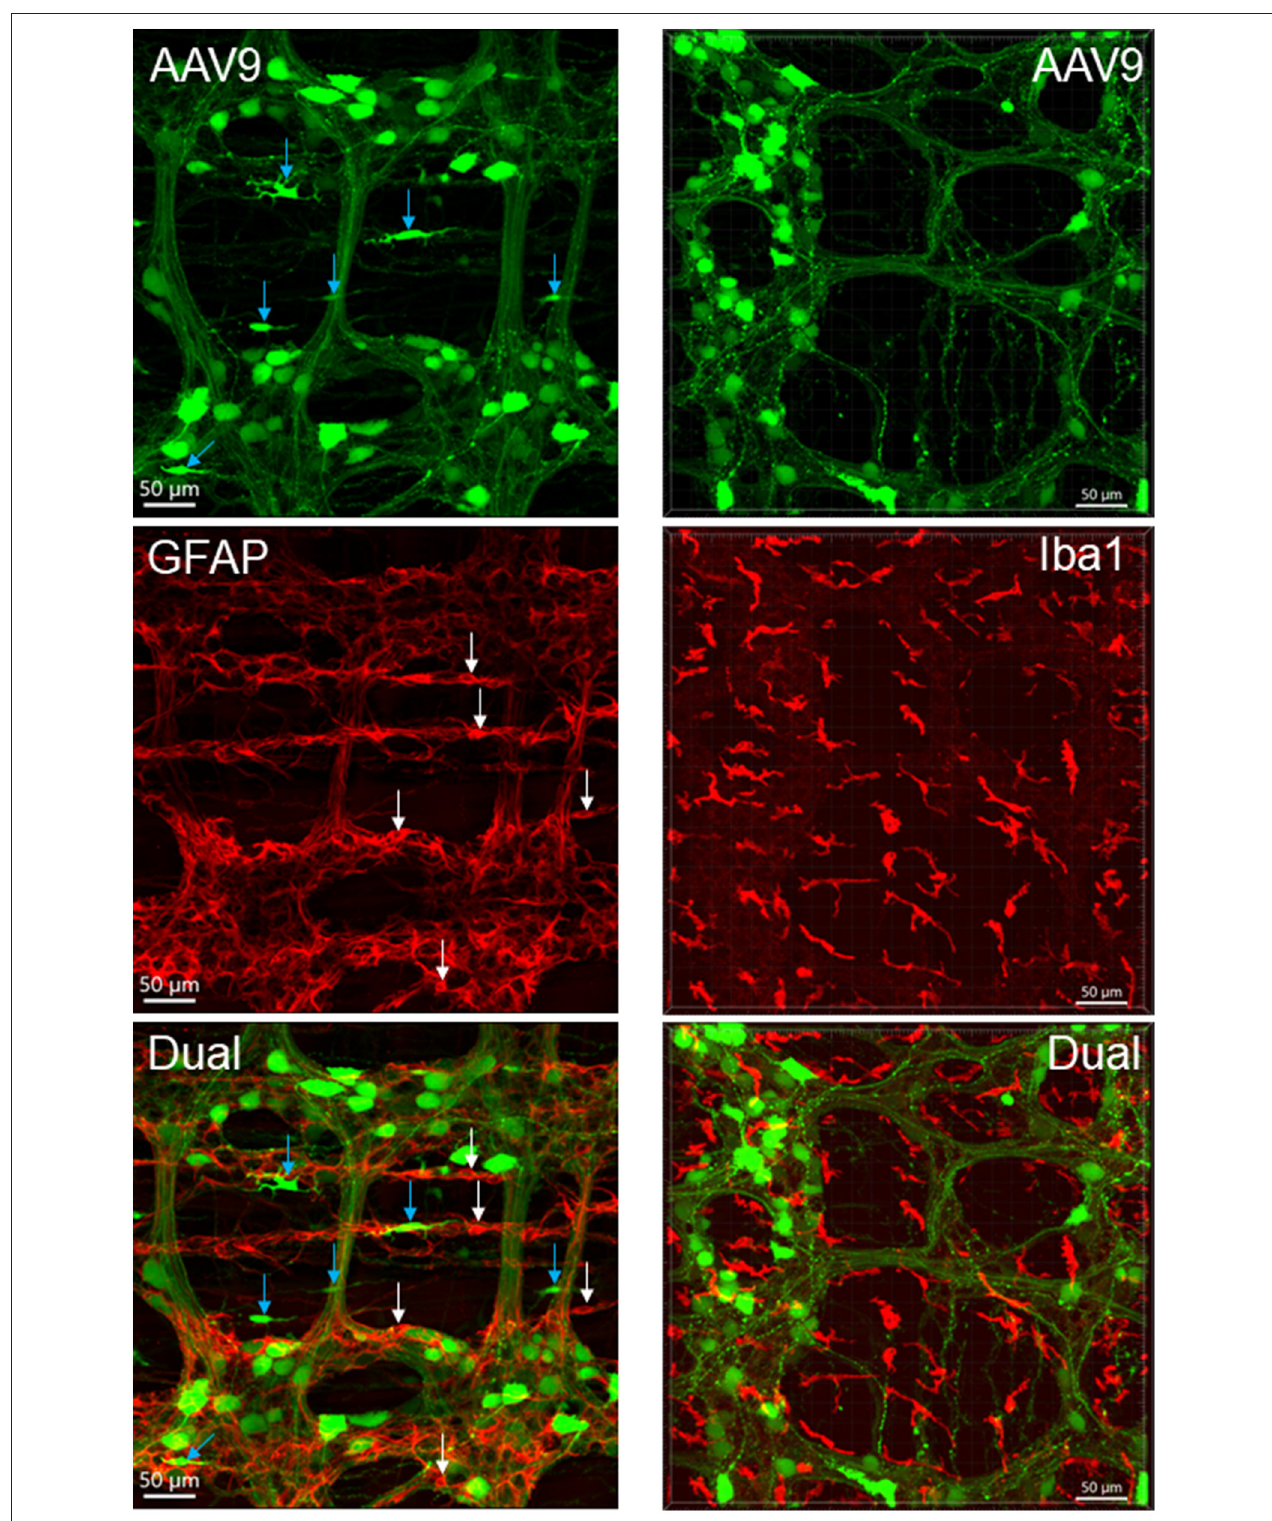
FIGURE 6 | AAV9 transduction in the myenteric plexus whole mount preparations of the mouse proximal colon combined with immunofluorescence of glial fibric acid protein (GFAP) for glial cells (left panels) and ionized calcium binding adaptor molecule 1 (Iba1) for macrophages (right panels). AAV9-CAG-GFP was retro-orbitally injected at 3.3 x 10 11 GC/mouse 3 weeks before. No AAV9-transduced cells were GFAP-ir or Iba1-ir. White arrow indicate GFAP-ir glial cell bodies, and blue ones indicate AAV9 transduced non-neuronal cells which were not GFAP-ir. Many Iba1-ir cells were located near or inside the ganglia and interganglionic strands (bottom-right